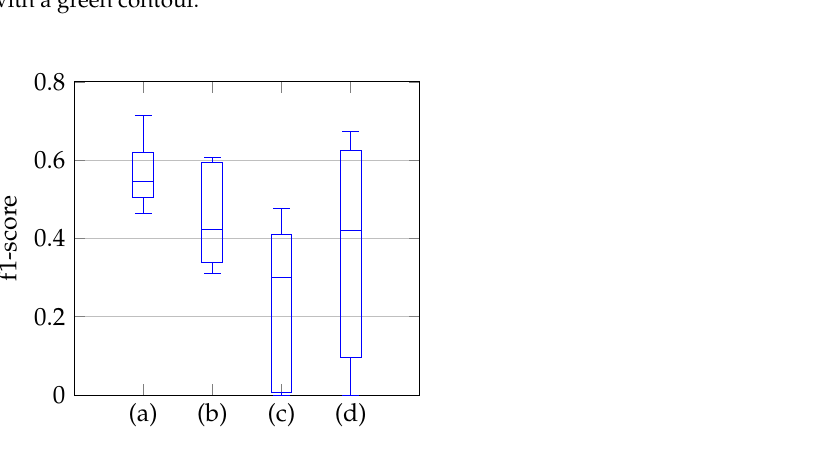
Figure 8. Segmentation of the mitral valve (red contour), depending on λ 2 and λ 3 of Equation (8), with the entries in ˆ W ˆ H appear in green and the entries in ˆ S in blue; the ground truth is highlighted with a green contour.